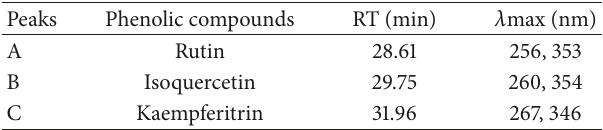
Table 2: Retention times (RT) and maximum absorption ( 𝜆 max) of the phenolic standards and their correlation with the compounds of Morus nigra (EEMn) leaves